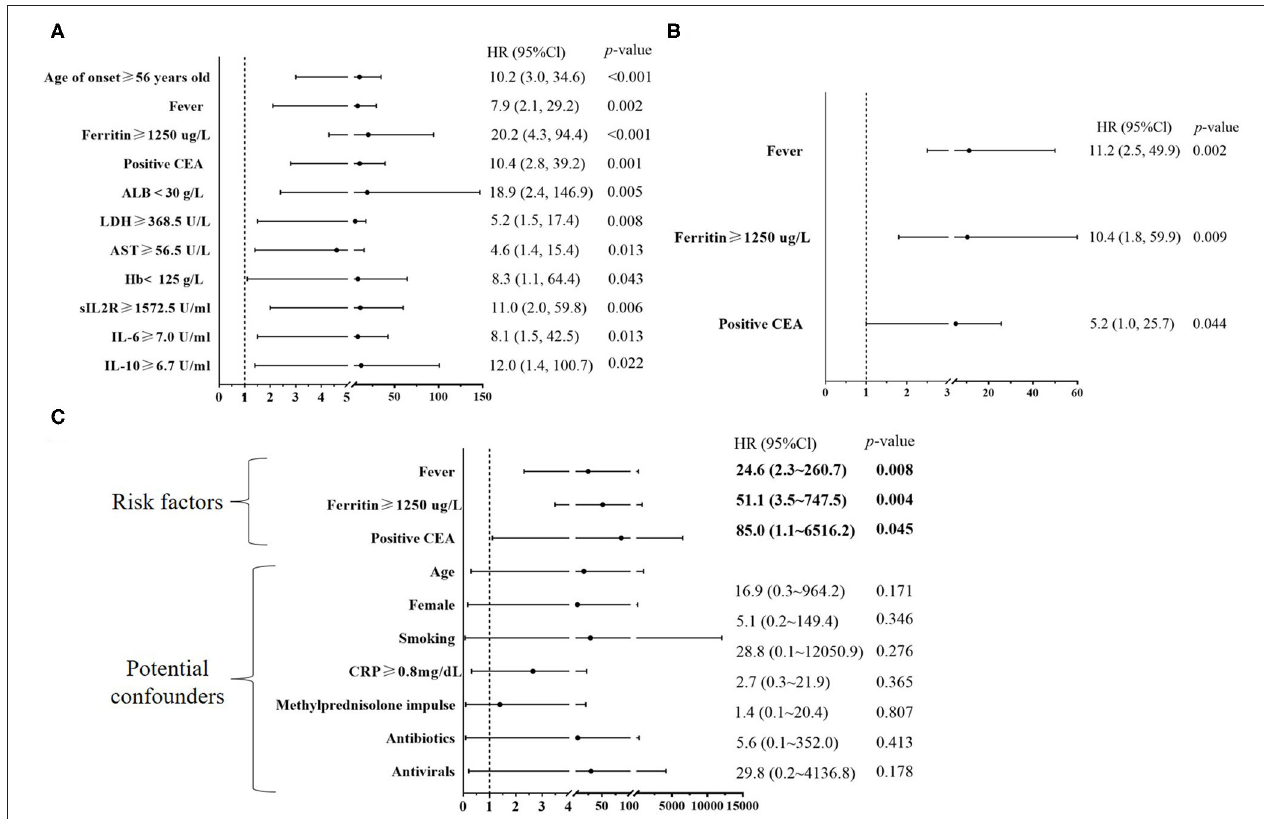
FIGURE 3 | Baseline risk factors for six-month all-cause mortality in patients with anti-MDA5-positive DM. (A) A univariate Cox regression was performed to analyze baseline risk factors identified by the survival curve analysis of Figure 2 ; (B) A stepwise multivariate Cox regression was performed to analyze eight baseline risk factors including onset ≥ 56 years old, fever, serum ferritin ≥ 1,250 µ g/L, positive carcinoembryonic antigen (CEA), albumin (ALB) < 30 g/L, lactate dehydrogenase (LDH) ≥ 368.5 U/L, aspartate aminotransferase (AST) ≥ 56.5 U/L, and hemoglobin (Hb) < 125 g/L. The stepwise multivariate Cox regression followed the rule that variables were included when the p -value was < 0.05 or removed when the p -value was was > 0.10. (C) Another multivariate Cox regression was used to adjust the potential confounders including age, sex, smoking, differential medications between the survivors and the non-survivors, and CRP ≥ 0.8 mg/dL. IL,